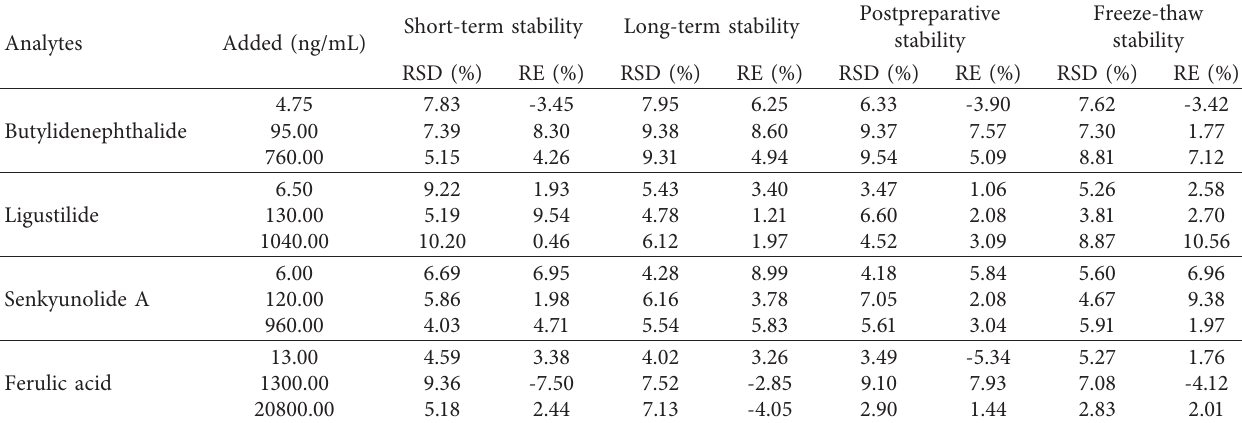
Table 4: Stability of butylidenephthalide, ligustilide, senkyunolide A, and ferulic acid in rat plasma ( n � 6).